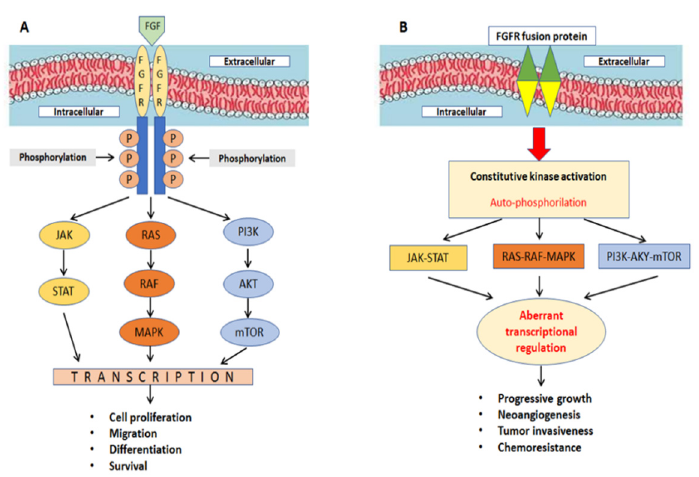
Figure 1. ( A ) FGFR is activated under physiologic conditions by its natural ligands. ( B ) FGF signaling can be activated by ligand-independent mechanisms.